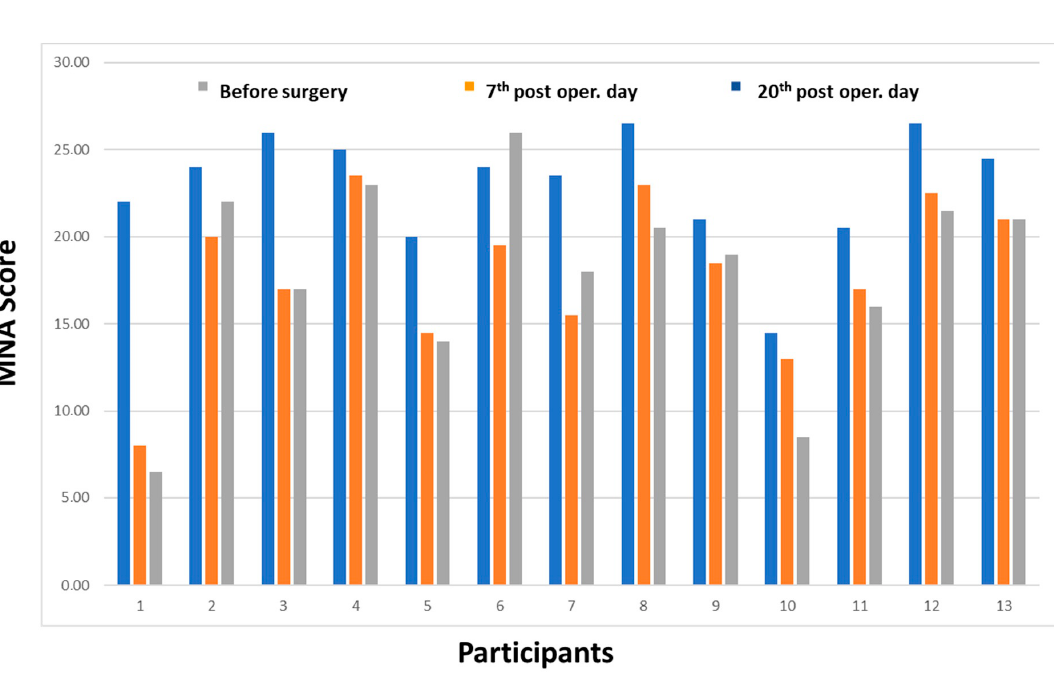
Figure 1. MNA scores in 3 times.